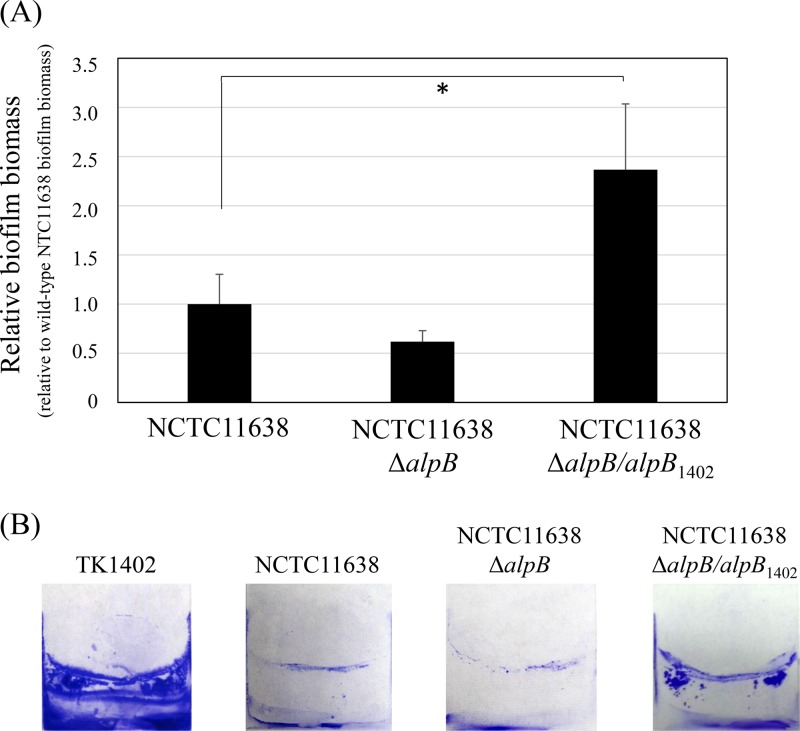
Biofilm formation by wild-type NCTC11638, an alpB mutant strain (NCTC11638ΔalpB), and NCTC11638ΔalpB with TK1402 alpB restored (NCTC11638ΔalpB/alpB1402). (A) Intact alpB from strain TK1402 was restored into the NCTC11638ΔalpB strain, and biofilm-forming ability was analyzed. The results were expressed as the means ± 1 standard deviation from at least three independent experiments. (B) CV-stained biofilms of wild-type TK1402 (TK1402), wild-type NCTC11638 (NCTC11638), and the NCTC11638ΔalpB and NCTC11638ΔalpB/alpB1402 strains grown on the surfaces of glass coverslips in brucella-FCS. An asterisk indicates significant difference (P < 0.05) relative to the level of wild-type NCTC11638 biofilm biomass.